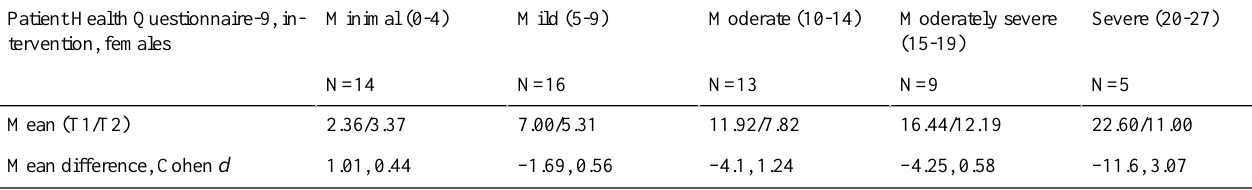
Table 7. Analysis of Patient Health Questionnaire-9 subgroups: male.